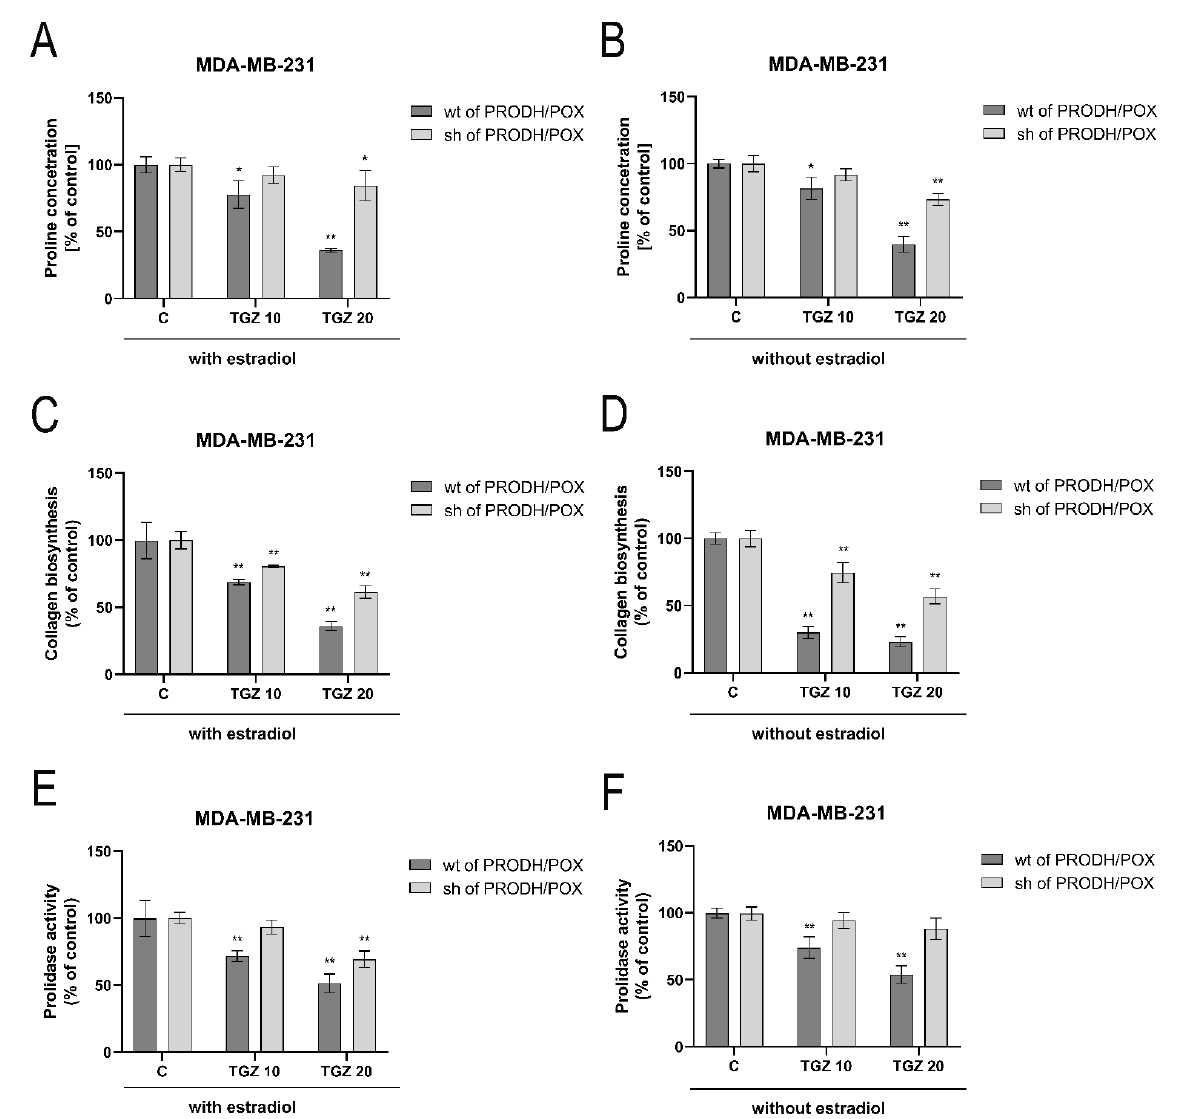
Figure 6. Proline concentration ( A , B ), collagen biosynthesis ( C , D ) and prolidase activity ( E , F ) in wild type (wt of PRODH/POX) and PRODH/POX-silenced (sh of PRODH/POX) MDA-MB-231 cells stimulated by troglitazone (TGZ) for 24 h in the presence ( A , C , E ) and absence ( B , D , F ) of estradiol. The mean values ± standard deviation (SD) from 3 experiments done in duplicates are presented. Asterisks (*) indicate statistical differences between studied cells compared to controls at * p < 0.01 and ** p < 0.001.